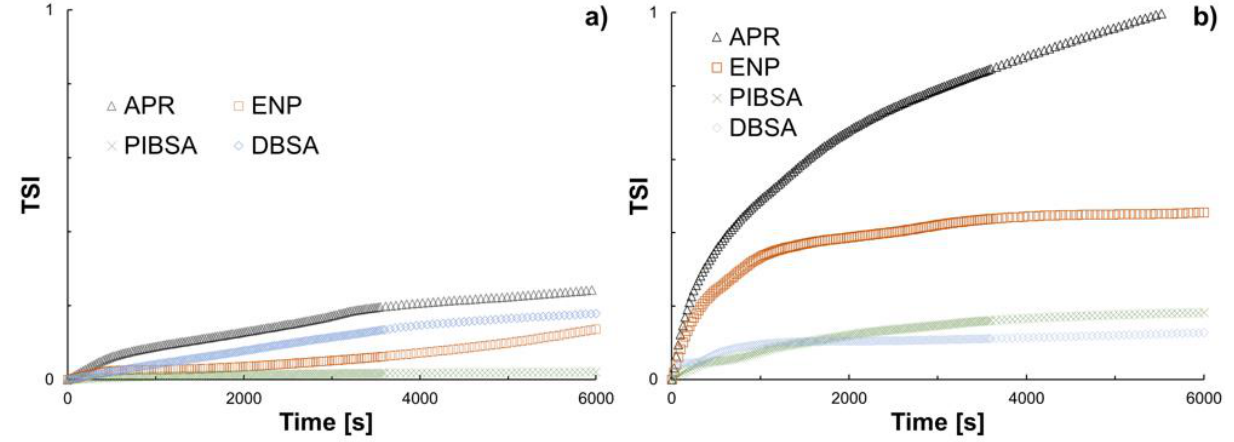
Figure 8. TSI as a function of time for the inhibitors/dispersants acting on ( a ) model 1 and ( b ) model 2.